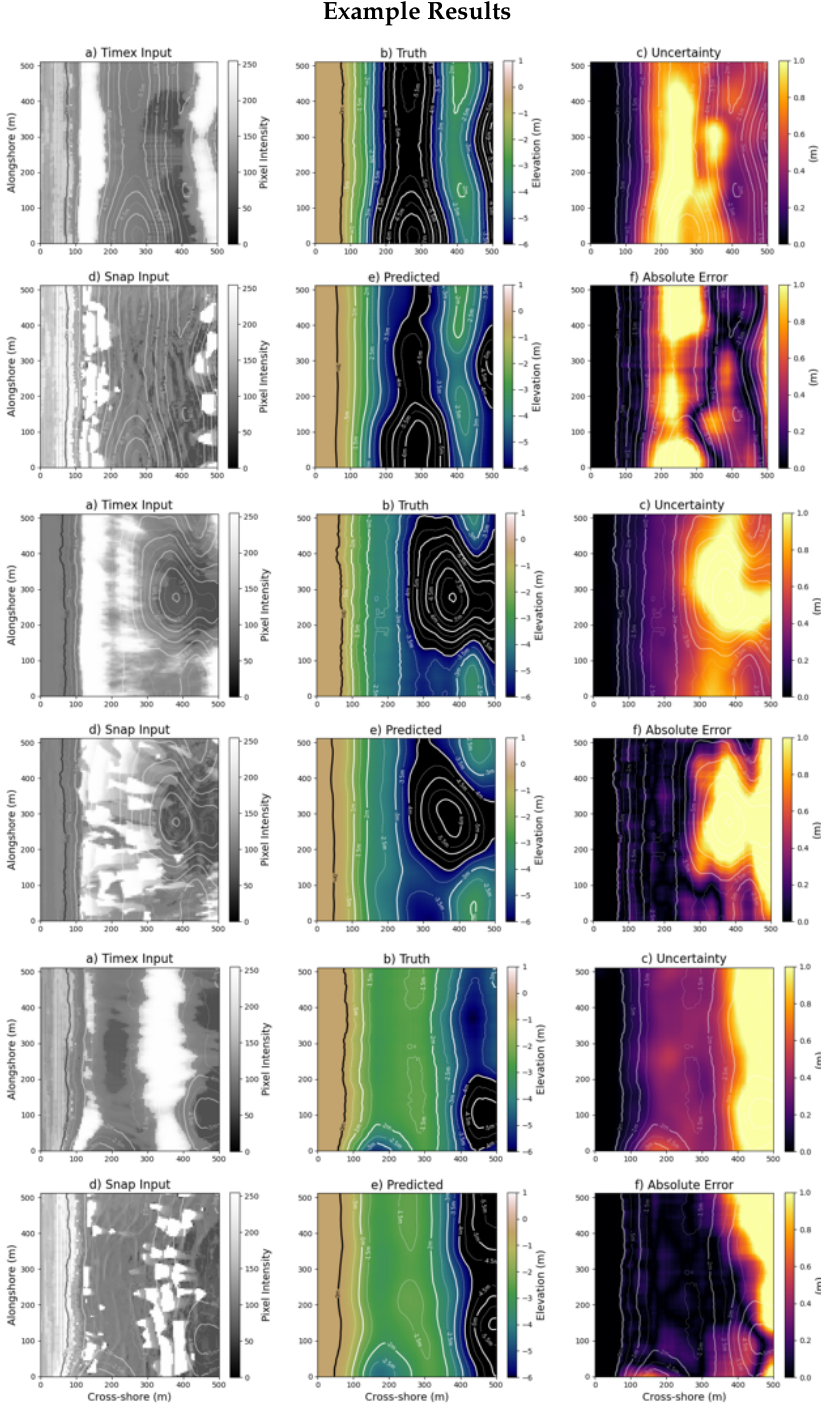
Figure 7. Three example results each marked ( a – f ), all from the model trained using both inputs. ( a ) Timex image input features. ( b ) Truth depth. ( c ) Spatial uncertainty using 2* the standard deviation of the ensemble spread. ( d ) Snapshot image input features. ( e ) The predicted depth. ( f ) Spatial absolute error map. Example one is H s = 1.9 m, D m = 87°, T p = 7.25 s. The second example is H s = 1.4 m, D m = 89°, T p = 10.63 s. The third example is H s = 1.2 m, D m = 86°, T p = 6.71